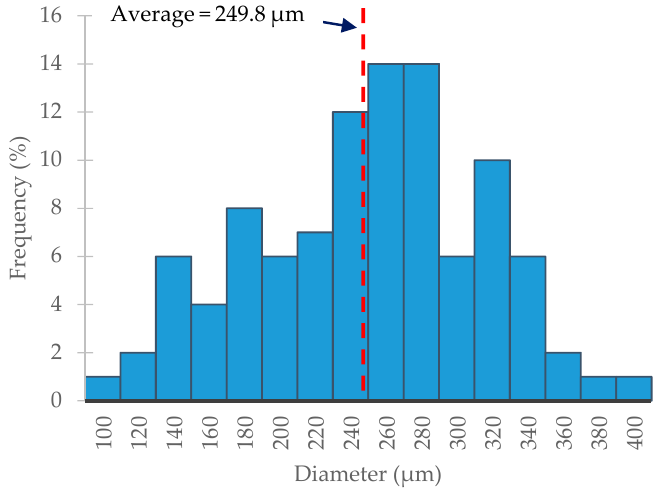
Figure 9. Diameter distribution of raw coconut fibers.